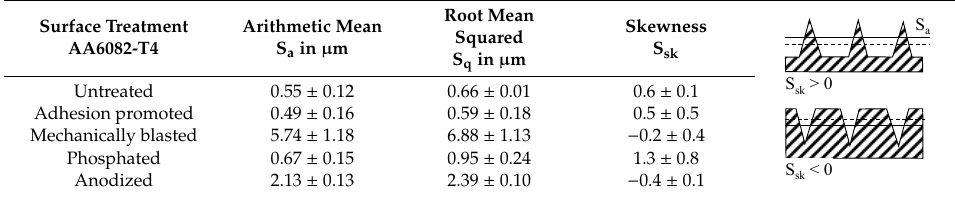
Figure 4. Laser scanning microscopy of ( a ) untreated and surface-treated aluminum alloy AA6082: ( b ) adhesion promoted, ( c ) mechanical blasted, ( d ) phosphated, and ( e ) anodized. Table 1. Roughness parameters of surface-treated aluminum alloy AA6082-T4 measured by laser scanning microscopy transvers to rolling direction.